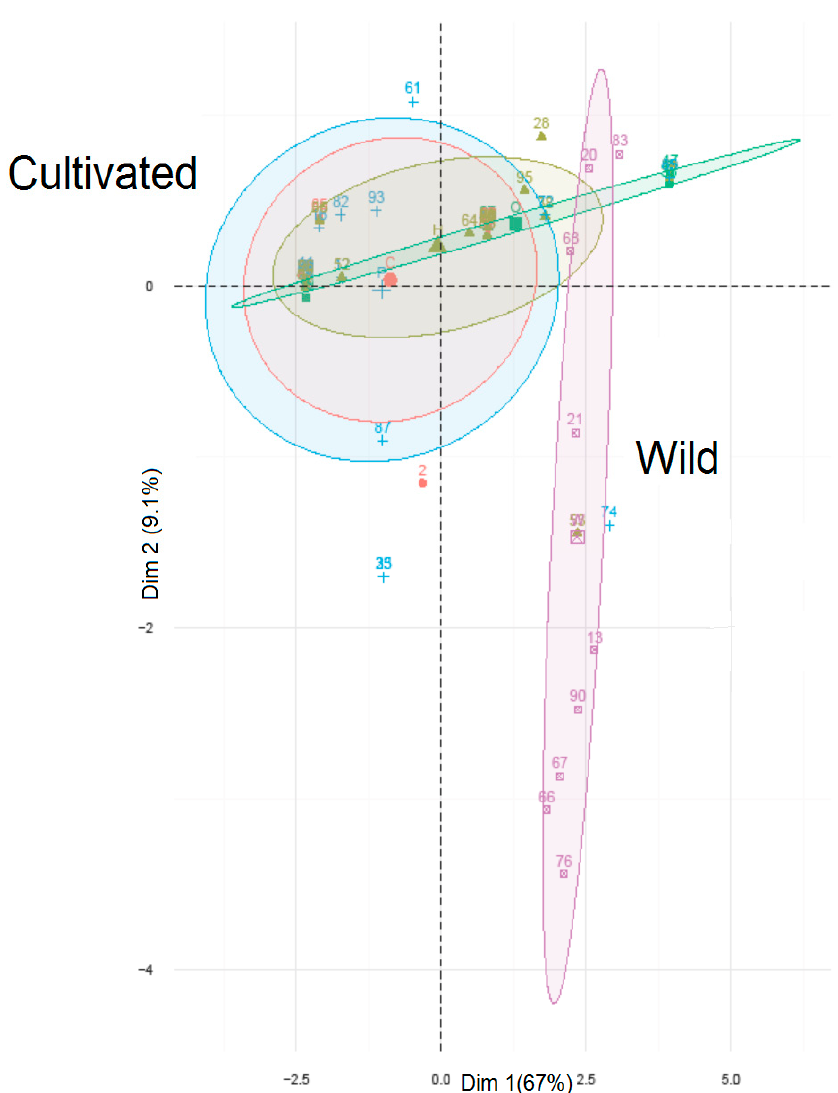
Figure 1. Principle coordinates analysis (PCoA) biplot of the gene Bv8_184910_pkon differentiates the wild and cultivated beets.